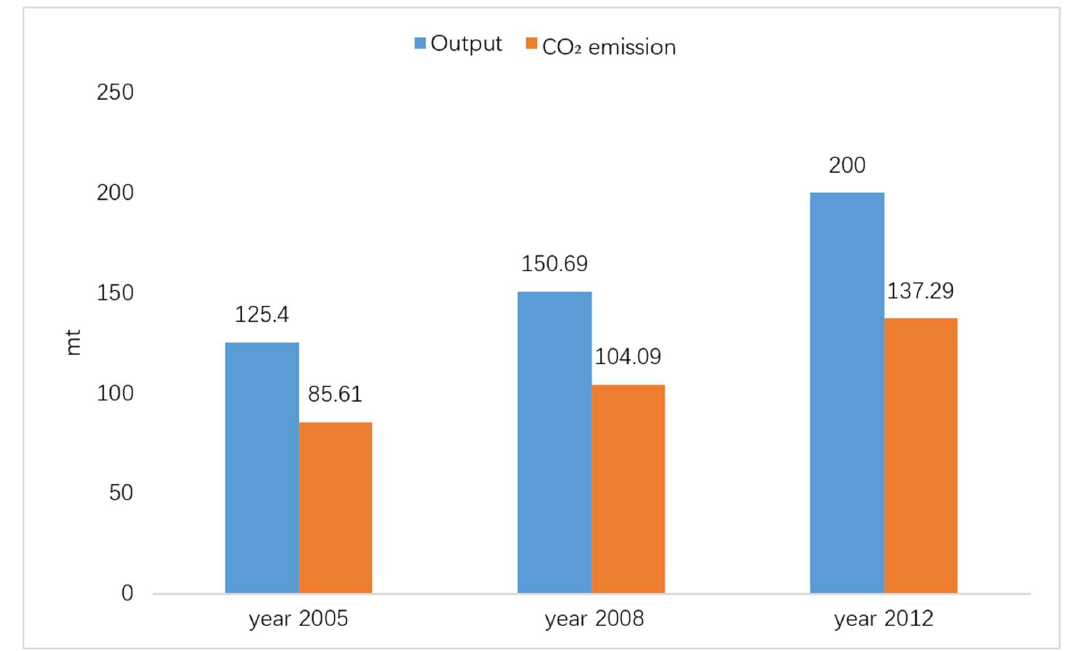
Figure 1. Greenhouse gas inventory data from China’s lime industrial Figure 1 Greenhouse gas inventory data from China’s lime industrial process.